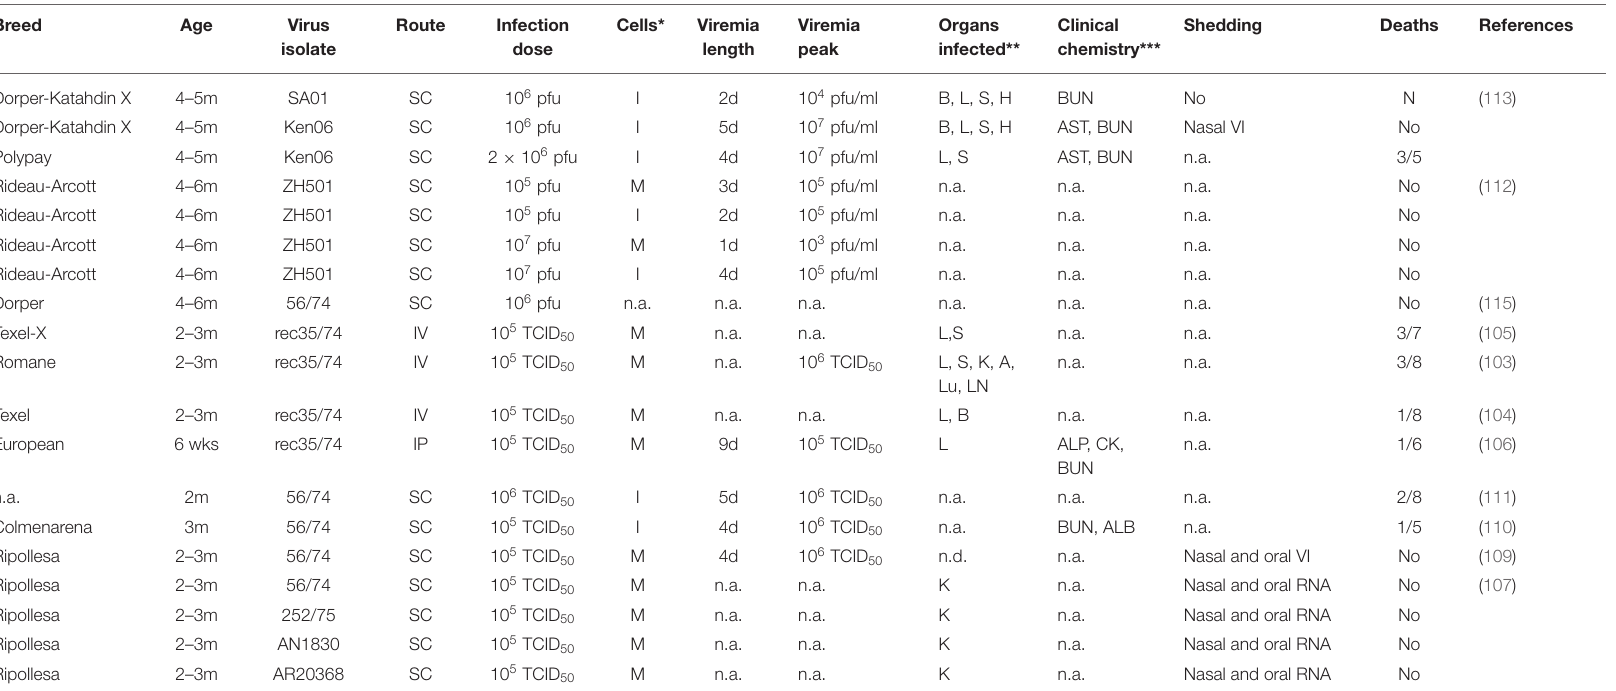
TABLE 2 | Summary of included sheep studies involving RVFV